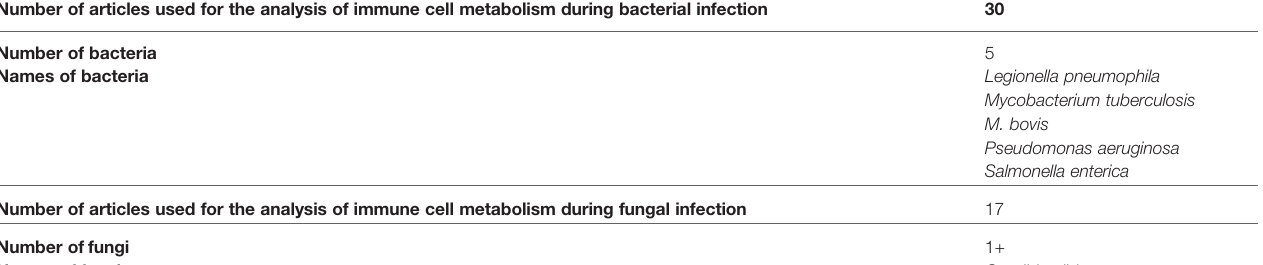
TABLE 1 | Number of analyzed articles and reviewed diseases in this review. Number of articles used for the analysis of immune cell metabolism during bacterial